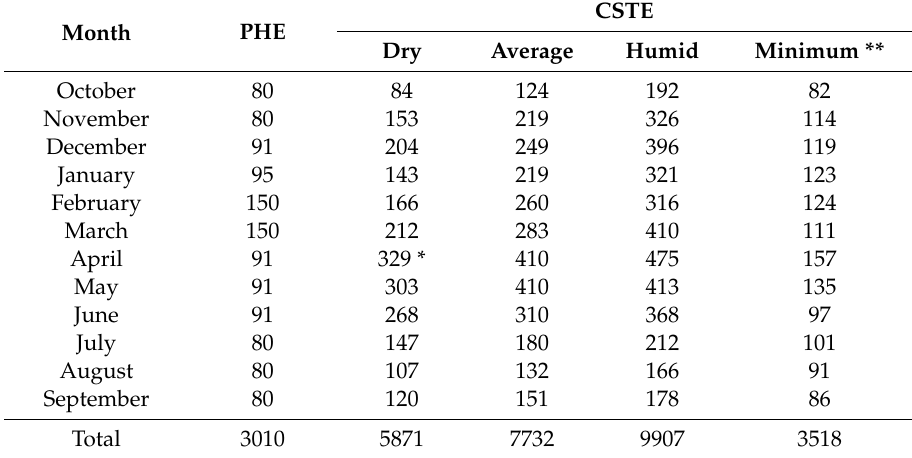
Table 1. E-flow proposals (monthly mean annual flow, m 3 / s; total, hm 3 / year) for the lower Ebro River and delta elaborated by the Spanish (PHE) and Catalan (CSTE) Governments. The PHE is the proposal presently in